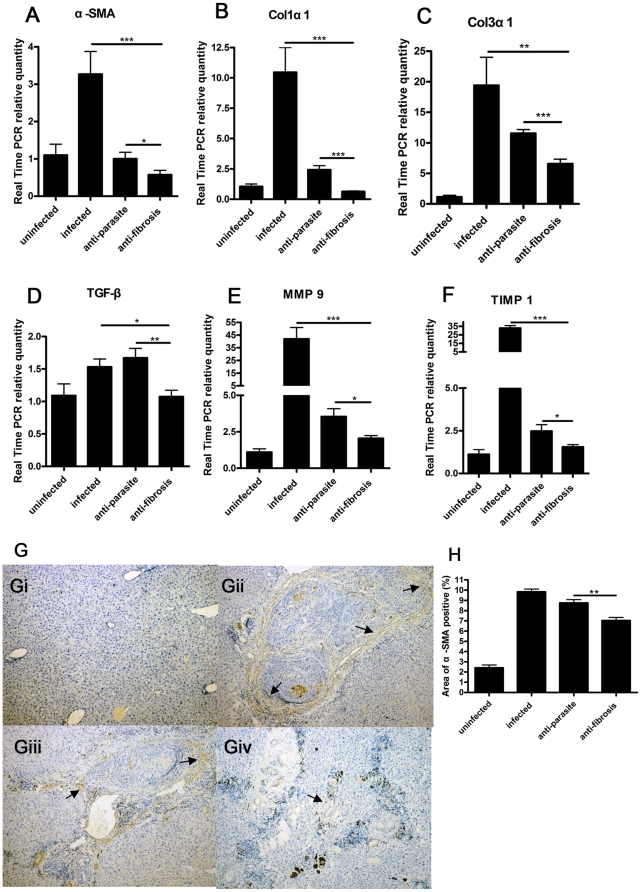
Anti-fibrosis treatment with prizaquantel inhibited expressions of liver profibrotic genes and α-SMA protein expression in mice 8 weeks post infection with Schistosoma japonicum.The expressions of mRNA were detected by Real Time PCR. (A) Expression of α-SMA. (B) Expression of Col1α1. (C) Expression of Col3α1. (D) Expression of TGF-β. (E) Expression of MMP9. (F) Expression of TIMP1. α-SMA protein expression was assessed by immunohistochemistry (G) Representative images of immunohistochemistry by light microscope (×100). Gi, uninfected; Gii, infected; Giii, anti-parasite; Giv, anti-fibrosis. Arrows showed the positive staining. (H) α-SMA positive areas were measured by software IPP6.0. (* p<0.05, ** p<0.01, *** p<0.001).